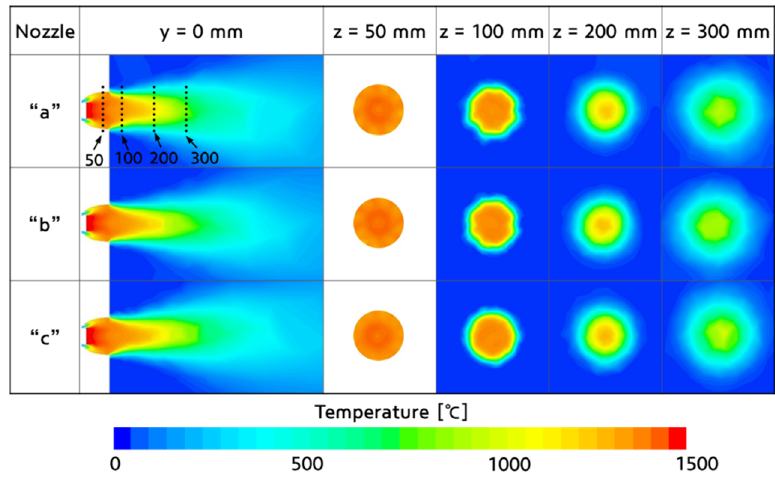
Figure 6. Comparison of the simulations in the combustion field ( φ = 1.1).